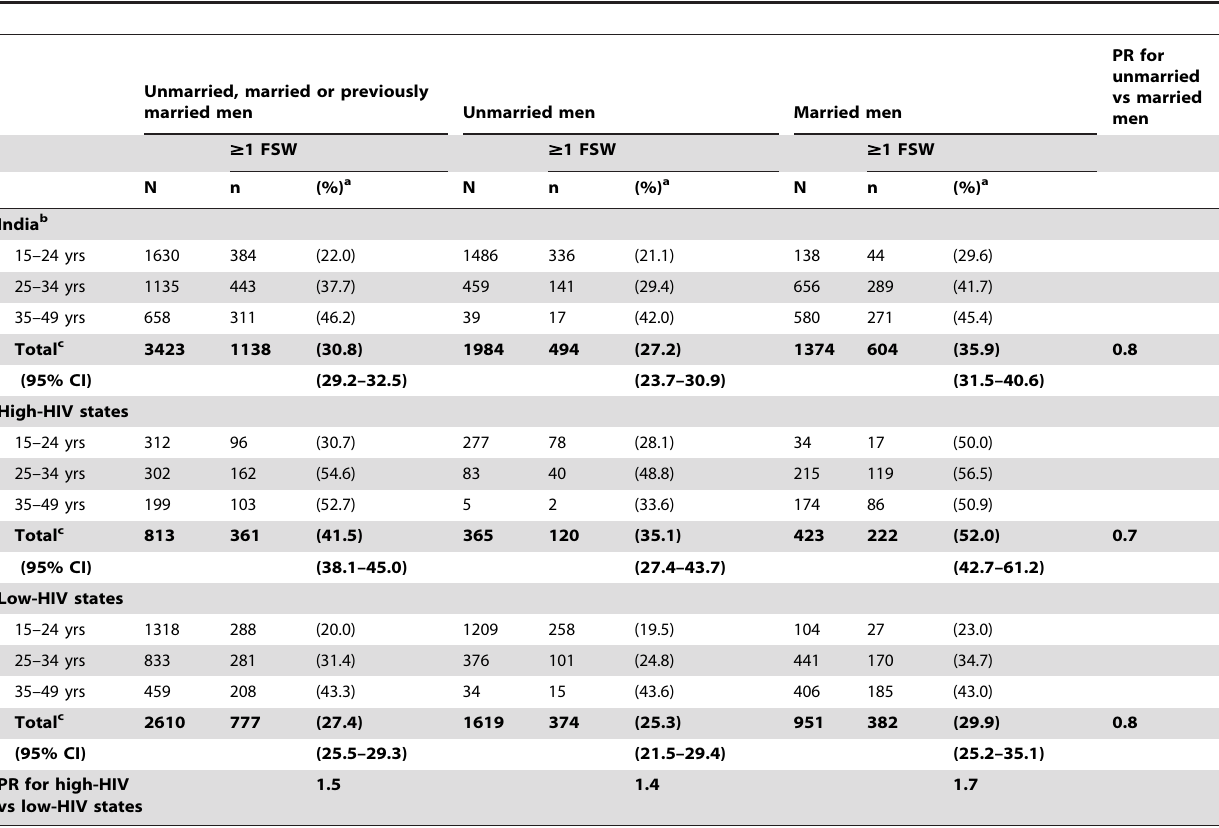
Table 2. Age-standardized prevalence of using female sex work among Indian men reporting any non-regular partner in the past year, by region and marital status,